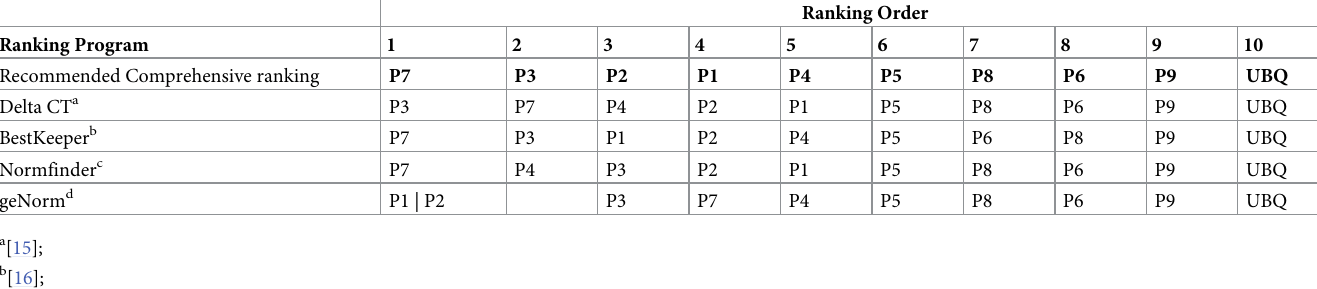
Table 3. Results from RefFinder comparing the qPCR profiles for each of the candidate reference